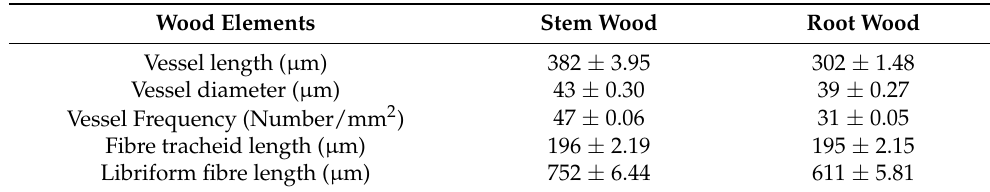
Table 3. Dimensions of wood elements (stem and root) of Kopsia fructicosa; values are the mean ± stan- dard error (n =